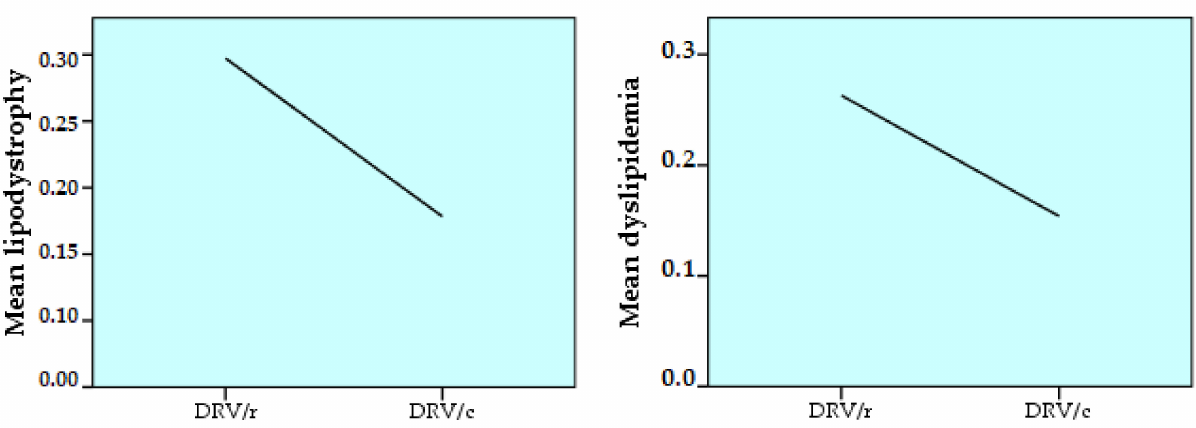
Figure 4. Pearson correlation between group 1 (DRV/r) and group 2 (DRV/c), regarding the prevalence of pre-existing lipodystrophy and dyslipidemia (SPSS, Line Area).